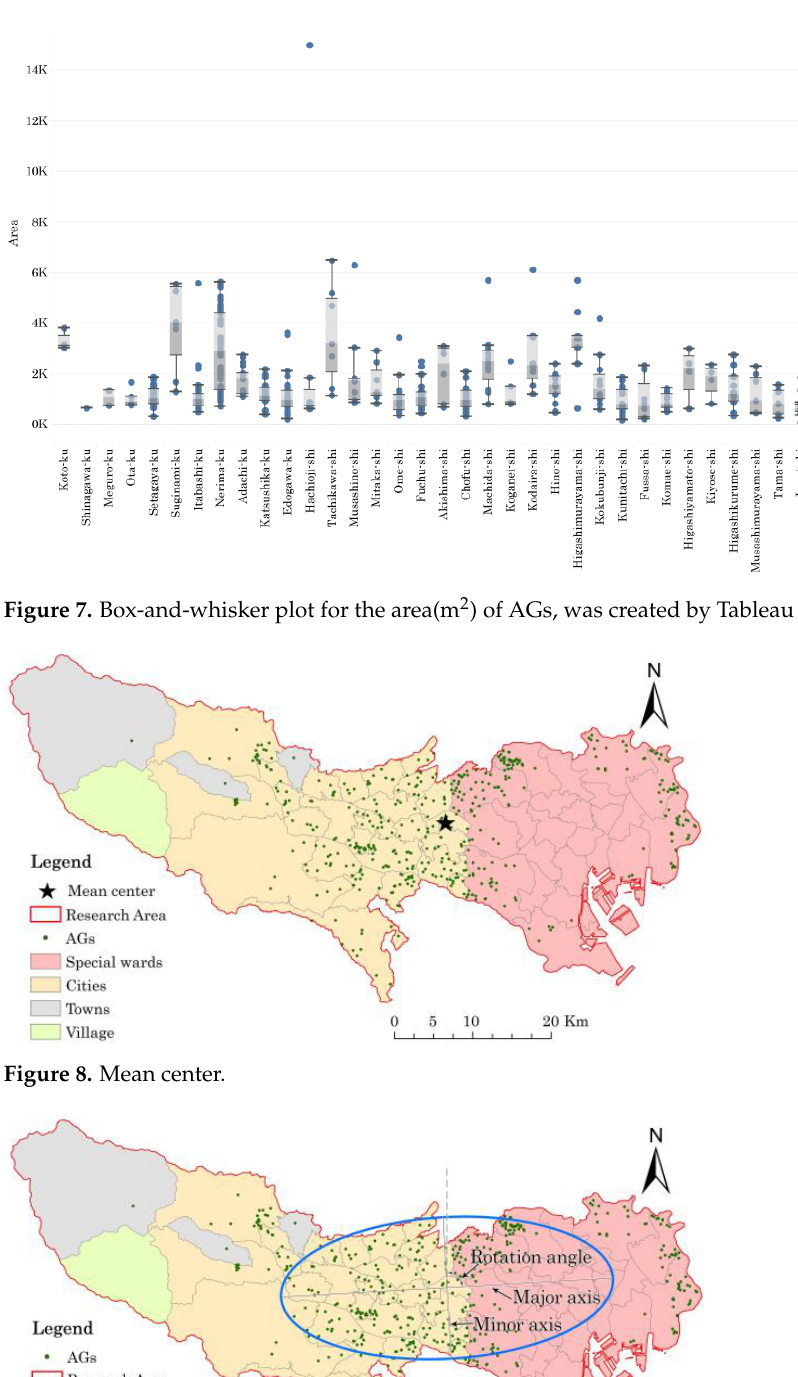
Figure 6. Box-and-whisker plot for the number of AGs plots, was created by Tableau 2020.4.